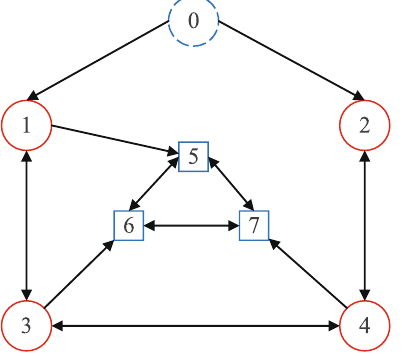
Figure 3. The interaction topology among 7 UAVs.